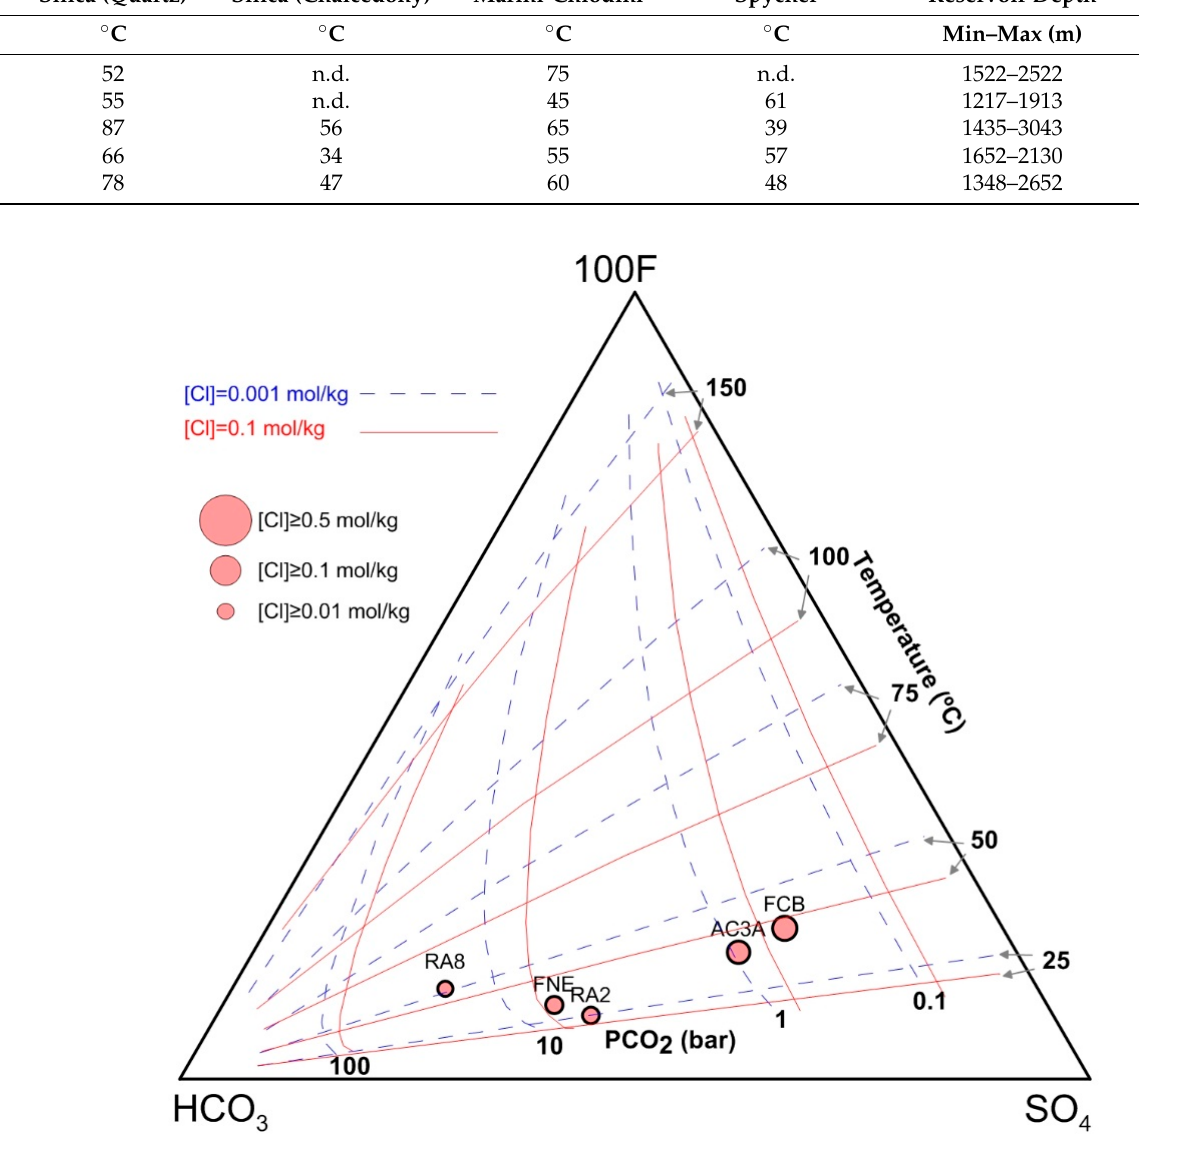
Figure 10. HCO 3 -SO 4 -F ternary diagram, modified from [63], for sampled waters. Continuous and traced lines represent equilibrium temperatures for chloride contents of 0.1 and 0.001 mol/kg, re- spectively.